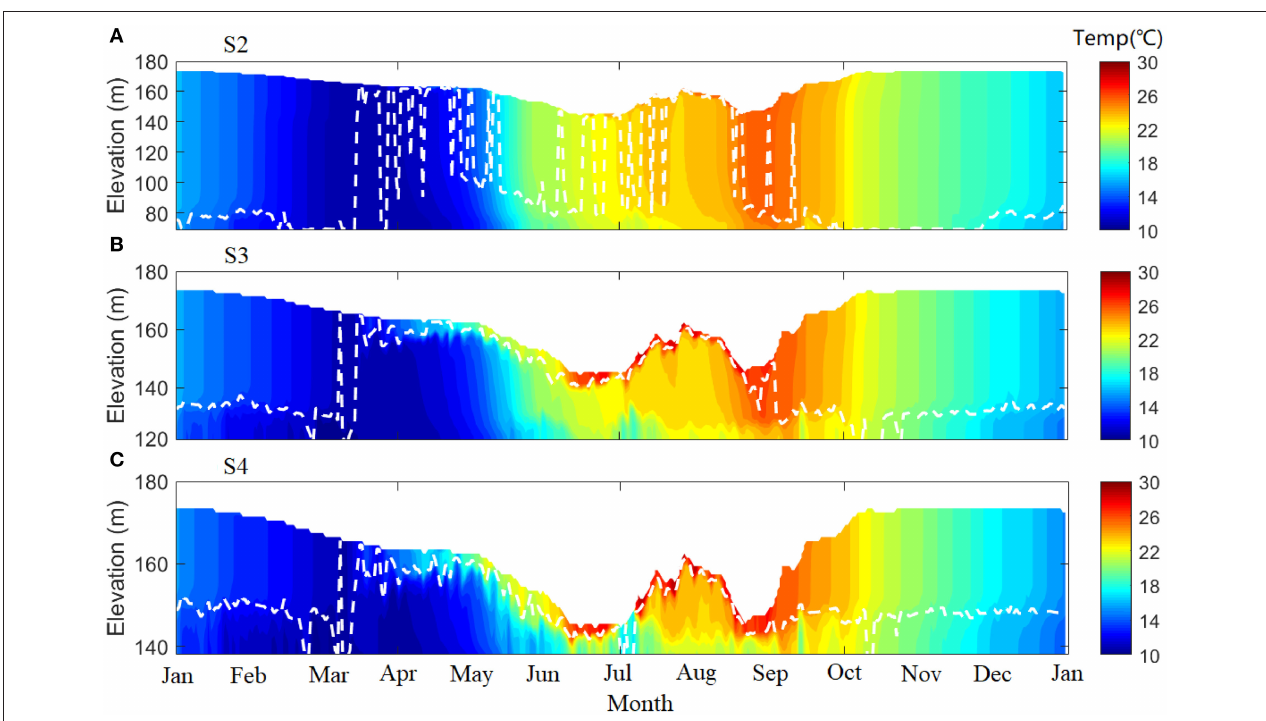
FIGURE 6 | Time series of simulated water temperature at the mouth (S2), middle (S3), and upper (S4) sites of the Xiangxi Bay in 2012 (A–C) . The white dash line shows the mixing depth ( < 0.5 ◦ C below surface